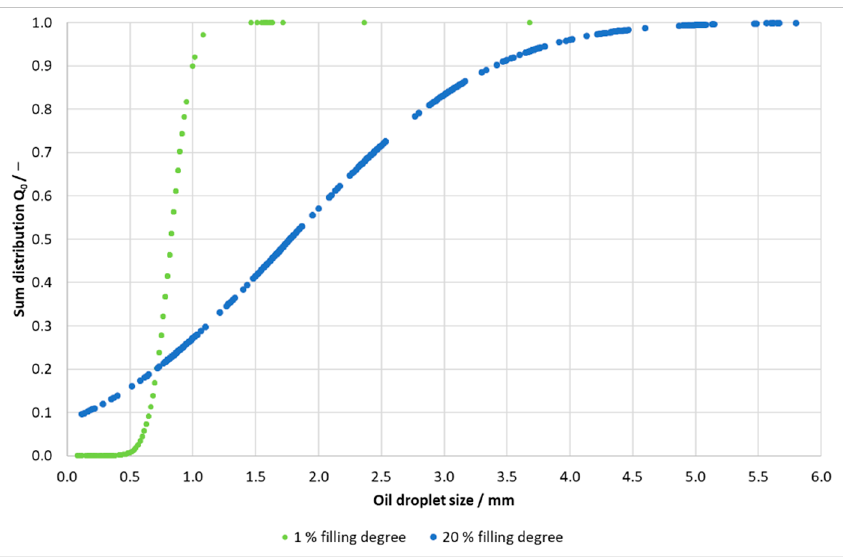
Figure 8. Sum distributions of the 1% (lowest polydispersity) and 20% (highest polydispersity) filling degrees.